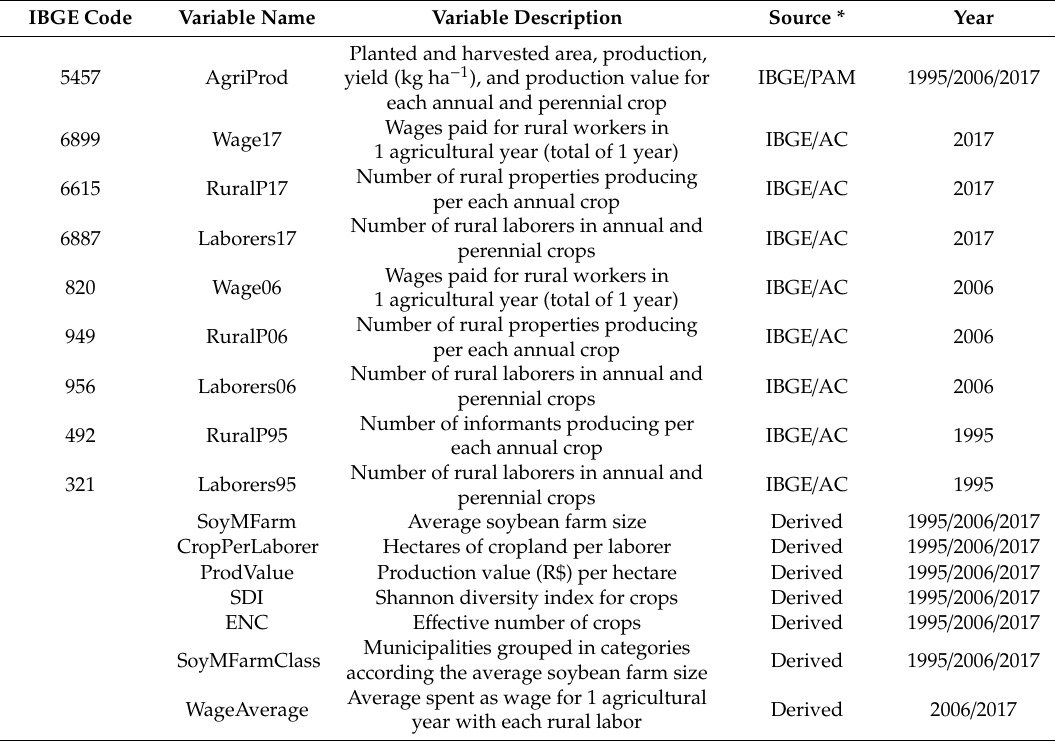
Table 1. Municipality-level data and variables used in this